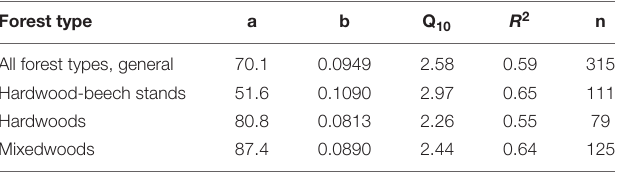
TABLE 3 | Parameter estimates and Q 10 values of exponential models ( Figure 3 ) between soil temperature respiration rates for each forest type individually and for all forest types combined (general